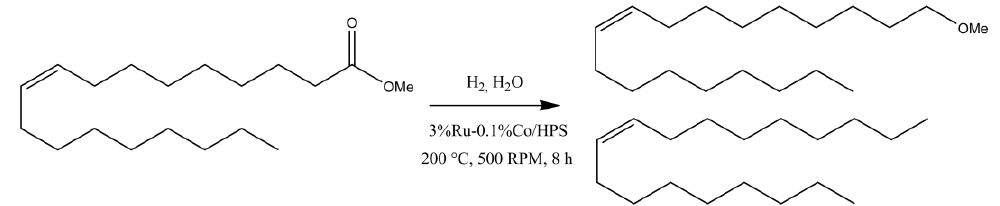
Scheme 5. Deoxygenation of canola